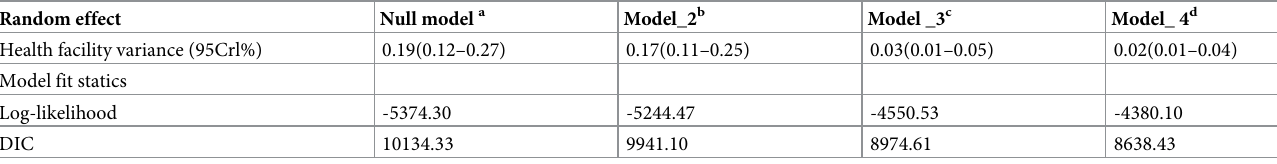
Table 10. Cluster level random effects parameter